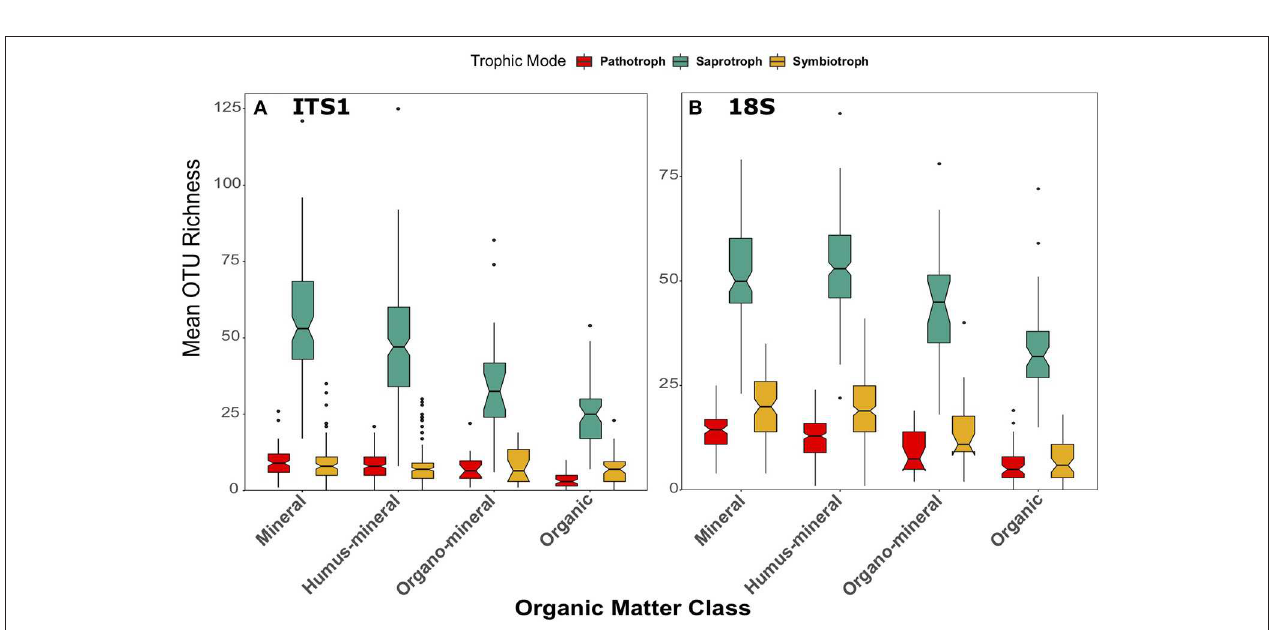
FIGURE 9 | Boxplots of richness of fungal OTUs matched to the pathotrophic, saprotroph, and symbiotroph trophic modes in FUNGuild for (A) ITS1 and (B) 18S datasets plotted against organic matter class. Organic matter classes are listed in order of increasing percent organic matter. Boxes cover the first and third quartiles and horizontal lines denote the median. Black dots represent outliers beyond the whiskers, which cover 1.5X the interquartile range. Notches indicate confidence interval around the median. Overlapping notches are a proxy for non-significant differences between medians. Black dots are outliers.